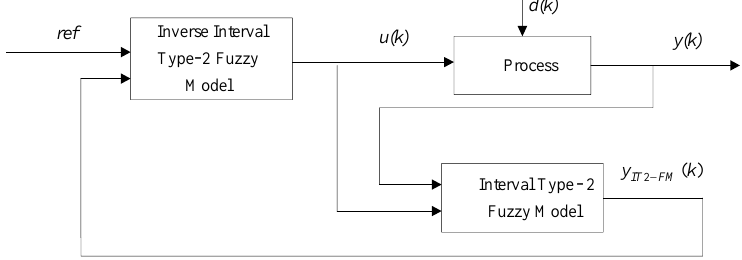
Figure 8. Inverse controller based on the IT2-FM design scheme.